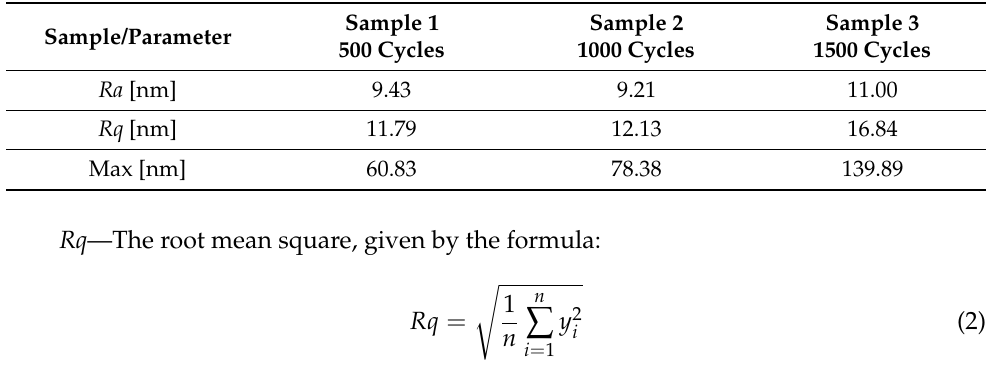
Table 1. Comparison of Ra , Rq parameter values and the maximum height value for three samples with different number of